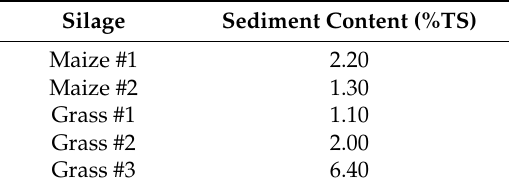
Table 3. Sediment contents in silages from operational biogas